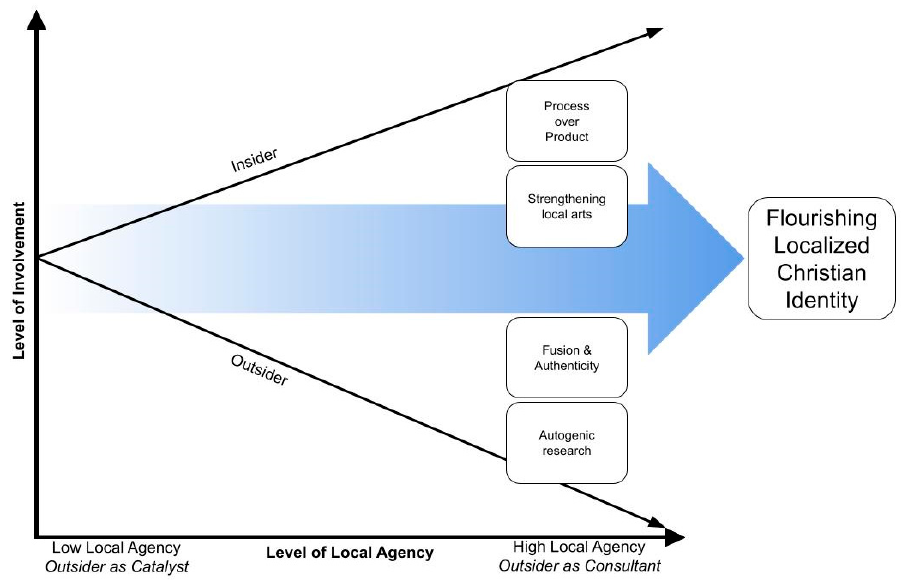
Figure 1. As local agency increases, the outsider role moves from catalyst to consultant. Catalyst to Consultant